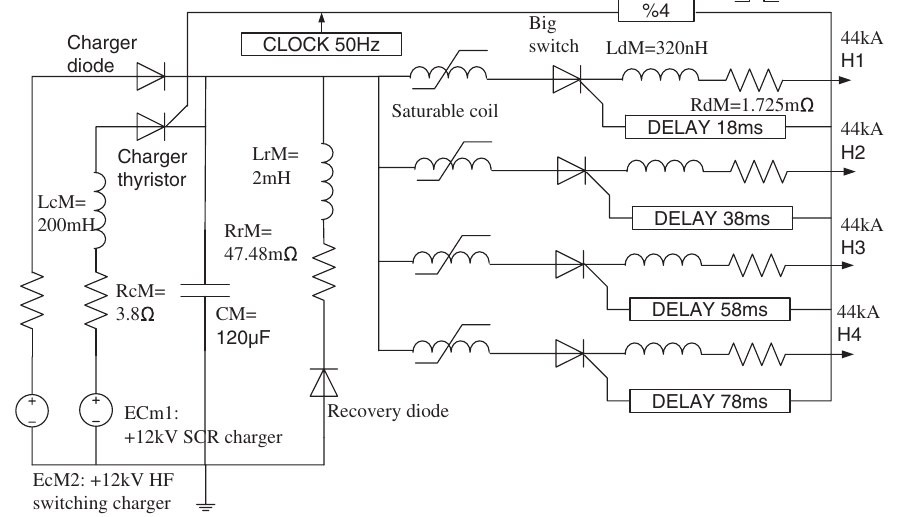
FIG. 22. Diagram of a power supply